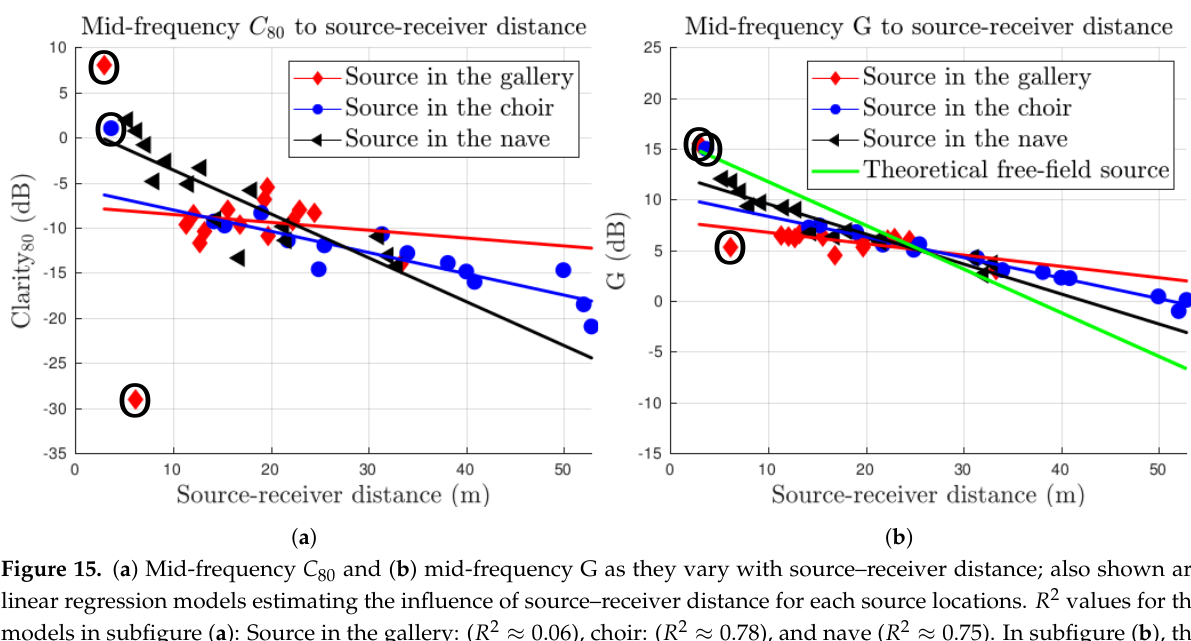
Figure 15. ( a ) Mid-frequency C 80 and ( b ) mid-frequency G as they vary with source–receiver distance; also shown are linear regression models estimating the influence of source–receiver distance for each source locations. R 2 values for the models in subfigure ( a ): Source in the gallery: ( R 2 ≈ 0.06), choir: ( R 2 ≈ 0.78), and nave ( R 2 ≈ 0.75). In subfigure ( b ), the corresponding values are gallery: R 2 ≈ 0.48, choir: R 2 ≈ 0.98, and nave: R 2 ≈ 0.92. In subfigure ( b ), the regression line for a theoretical omnidirectional source in free field is also shown. Highlighted data points have been excluded from the regression lines. These correspond to configurations entirely within the gallery or choir and the outlier case when the source is in the gallery and the receiver below